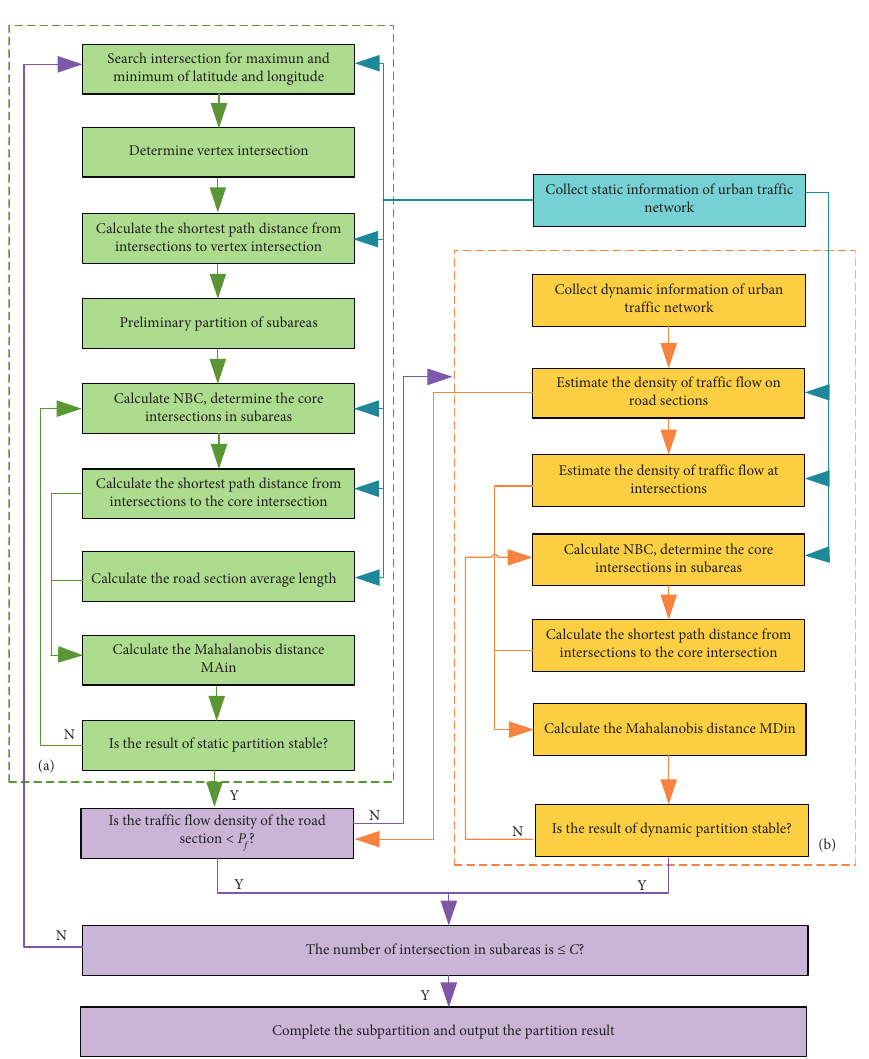
Figure 3: Traffic area subarea partition flowchart: (a) static stage; (b) dynamic